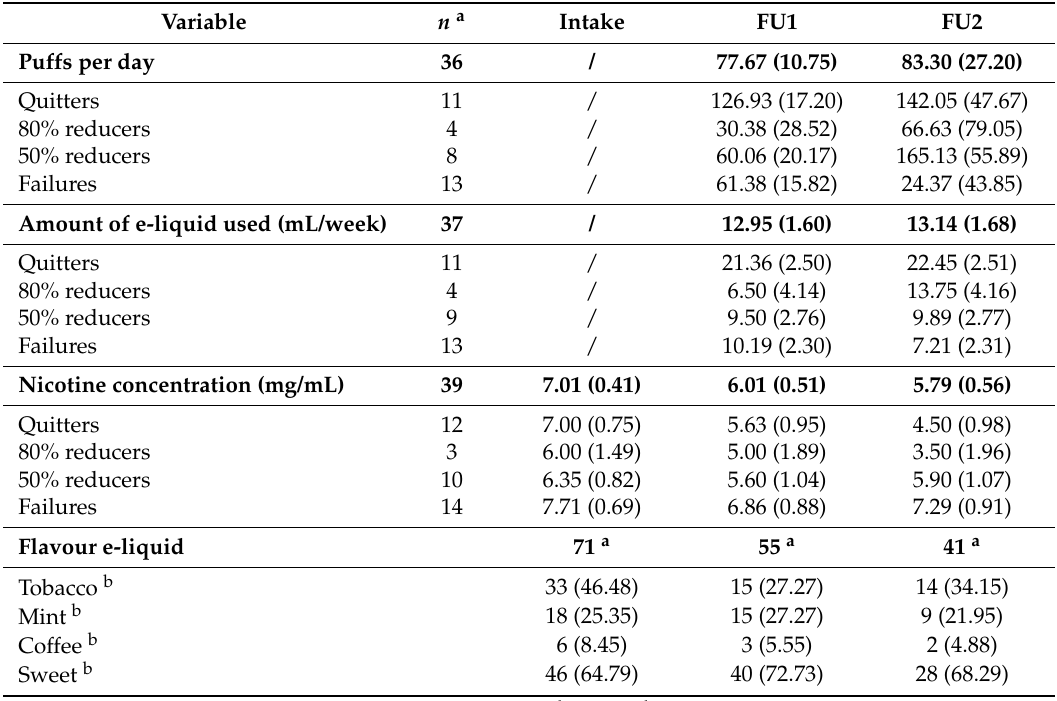
Table 4. User characteristics vapers: puffs per day, amount of e-liquid and nicotine concentration used, flavour